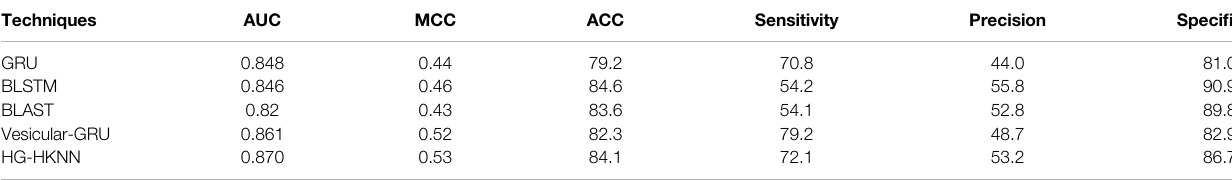
TABLE 5 | Comparison of our model with other existing technologies.